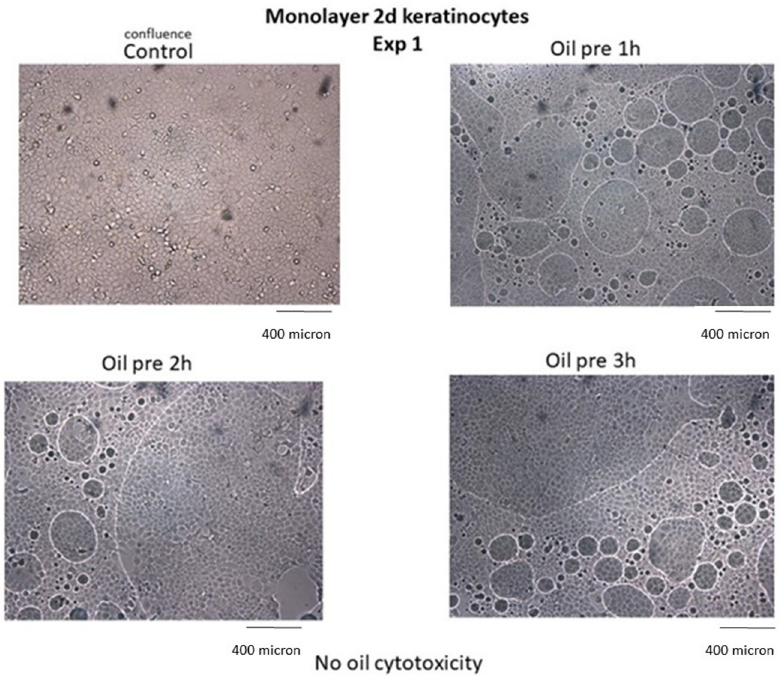
Figure 10. Ozonized oil (bubble oil in the culture medium 1, 2, 3 h) does not induce alterations in normal human keratinocytes. No change in cell viability, intercellular adhesion, and substrate adherence occur in ozonized oil-treated cells (Oil) as compared with untreated control.